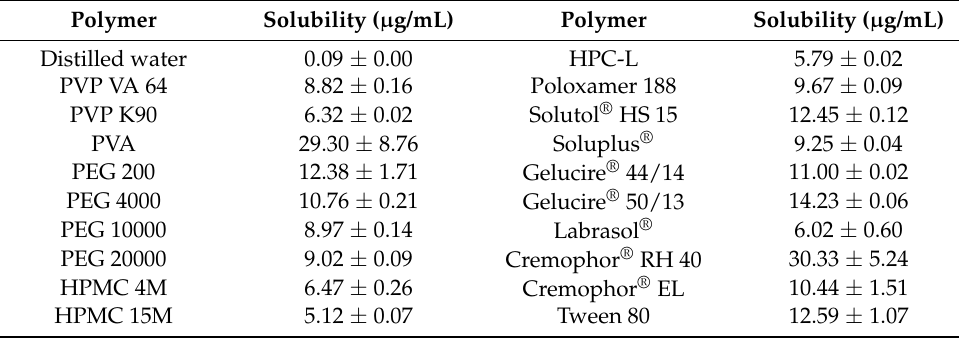
Table 3. Solubility of RXB in 1% aqueous polymer solution ( n = 3, means ± SD).